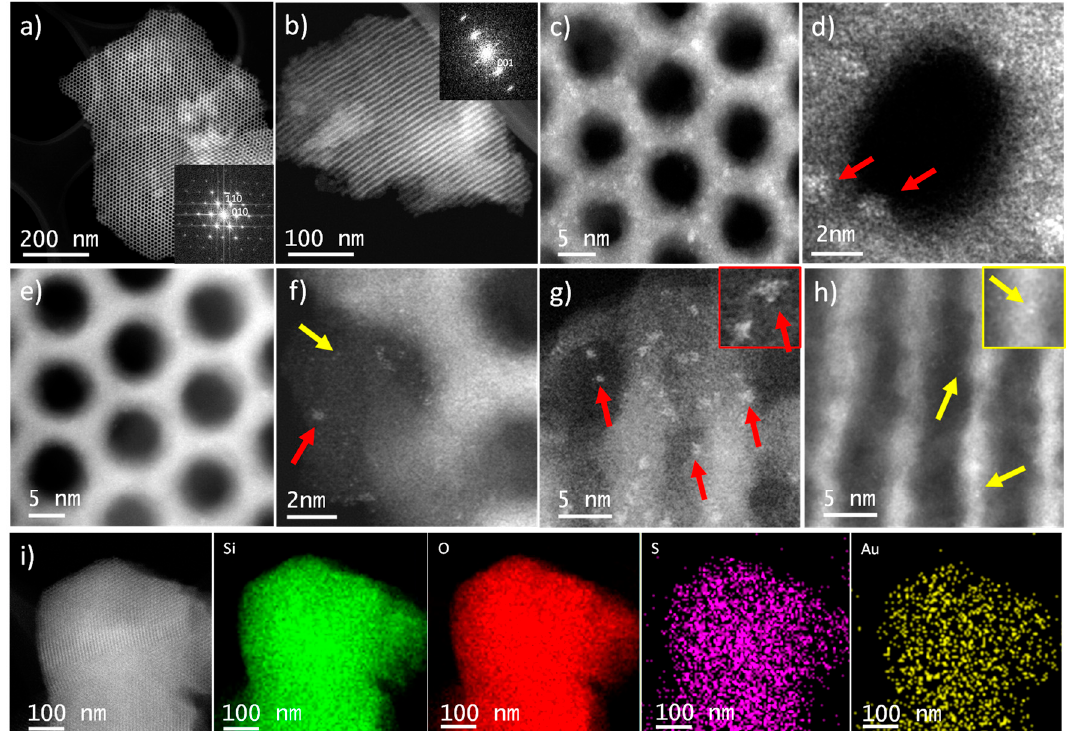
Figure 5. Cs-corrected STEM-HAADF analysis of the 3d-Au and 8d-Au materials. Low-magnification images of sample 8d-Au with ( a ) the channels of SBA-15 support parallel to the electron beam (FFT shown in inset) and ( b ) channels perpendicular to the electron beam (FFT in inset). A closer observation is shown in ( e ) and high-magnification images observing the SBA-15 channels parallel ( f ) and perpendicular to the electron beam ( h ); a closer observation of the single atoms is shown in the inset ( h ). Low-magnification images of sample 3d-Au are shown in ( c , d ), as well as a high-magnification image in ( g ), with a closer observation of the clusters shown in the inset. Color code: red arrows point to the Au clusters, while the yellow arrows point to the Au single atoms. ( i ) EDS chemical analysis showing the ADF image where the analysis was carried out and the chemical composition maps of each element.